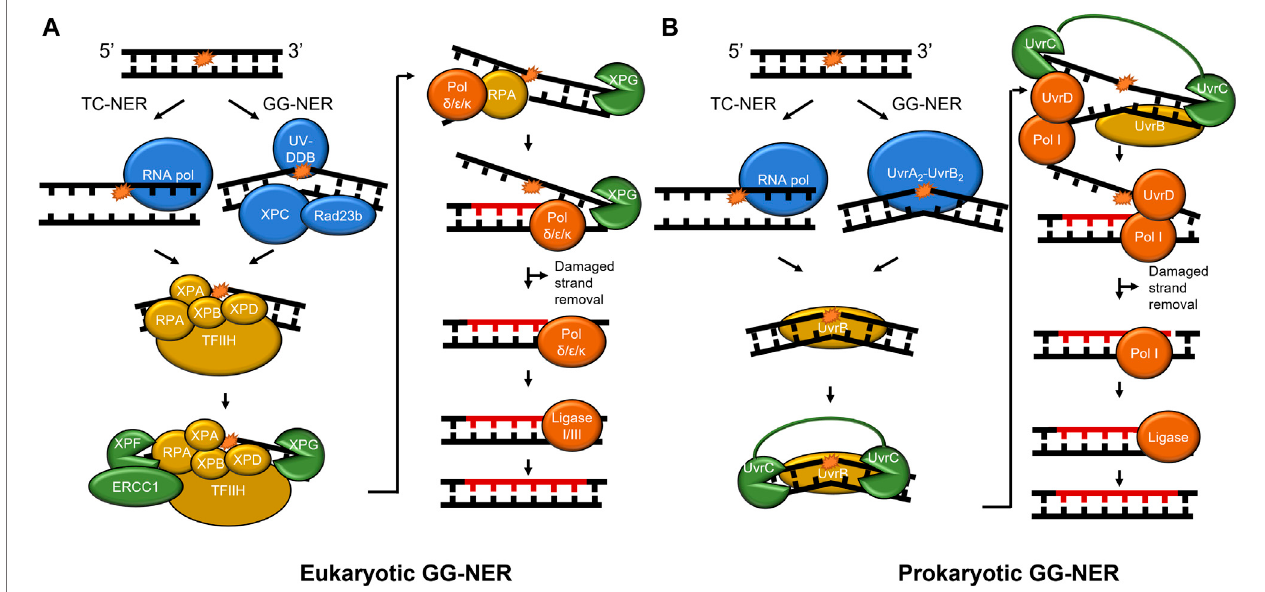
FIGURE1| NERpathwaysinmammalsandprokaryotes. (A) ThemammalianNERpathway.DamageisrecognizedbyUV-DDBandXPC-Rad23b (blue)inglobal- genome NER (GG-NER). Stalling of RNA polymerase (blue) initiates transcription-coupled NER (TC-NER). Then, damage veri fi cation is performed by TFIIH, XPA, RPA, ERCC1,XPB,andXPD(gold).XPFincisesonthe5 ′ sideofthedamageandXPGincisesonthe3 ′ sidefollowingDNAsynthesis(bothshowningreen).Lastly,therepairis performed by DNA polymerase δ / ε / κ and sealed by ligase (red). (B) Prokaryotic NER is performed by UvrA, UvrB, UvrC, UvrD, Pol I, and ligase. As in mammalian NER, RNA polymerase stalling initiates TC-NER, but GG-NER is initiated by UvrA 2 -UvrB 2 . For simplicity, CSA, CSB, CSA, XAB2, and HMGN1 are not shown in mammalianTC-NER, andMfdnotshowninbacterialTC-NER.A24 – 32nucleotideregion (A) and12 – 13nucleotideregion (B) isreplacedineachpathway (nottoscale). To show functional overlap across the pathways, proteins are color-coded with damage detection in blue, veri fi cation in gold, incision in green, and repair in